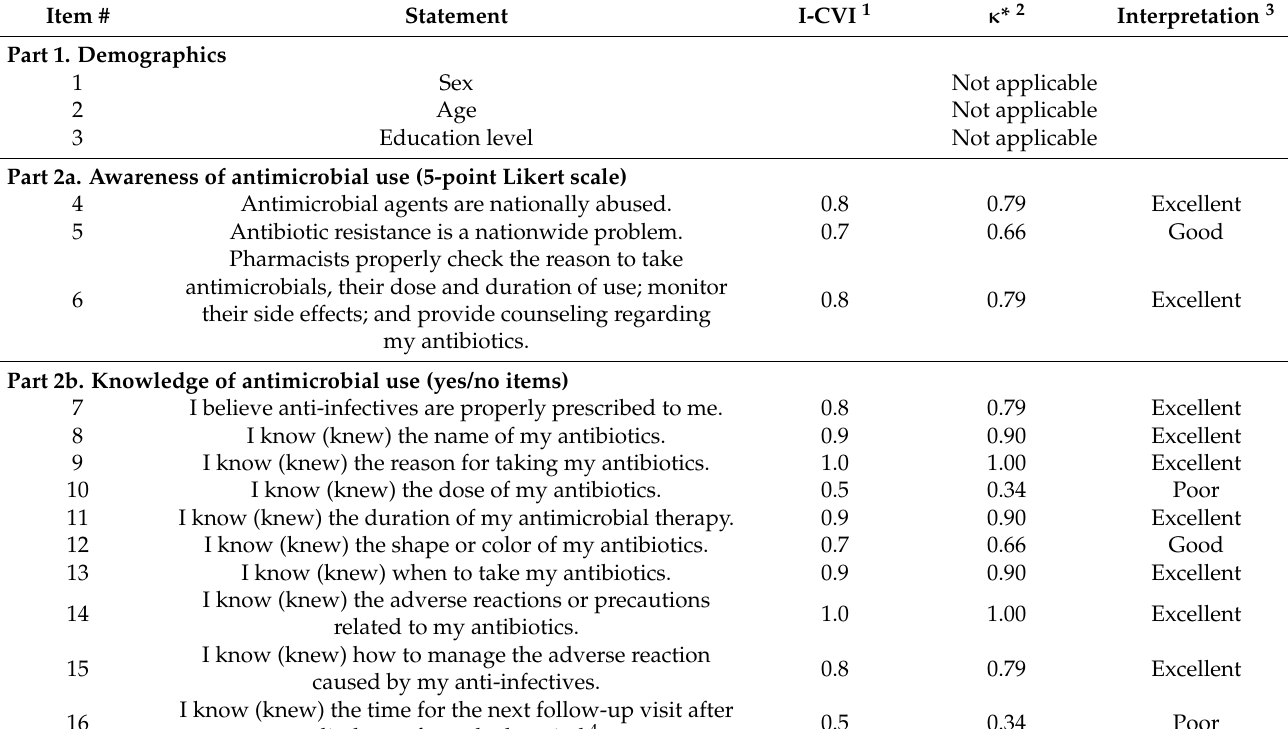
Table 1. The items in the questionnaire and content validity based on the responses from ten experts; 5-point Likert scale from strongly disagree (1) to strongly agree